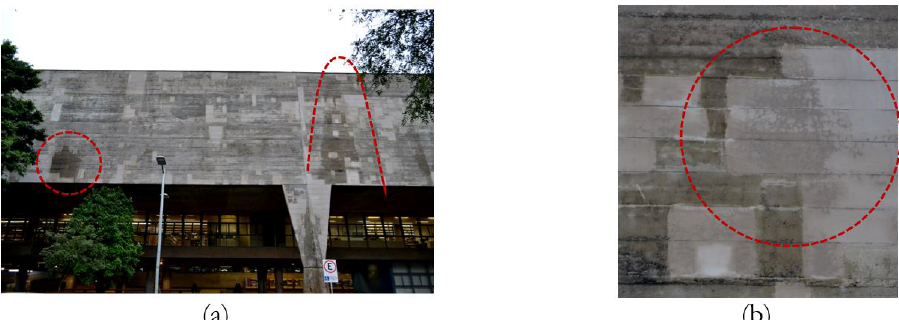
Figure 4. Partial views of SW façade: (a) typical moisture stains and (b) noticeable patch repair cracking after rain water penetration (Photos: Authors’ collection,